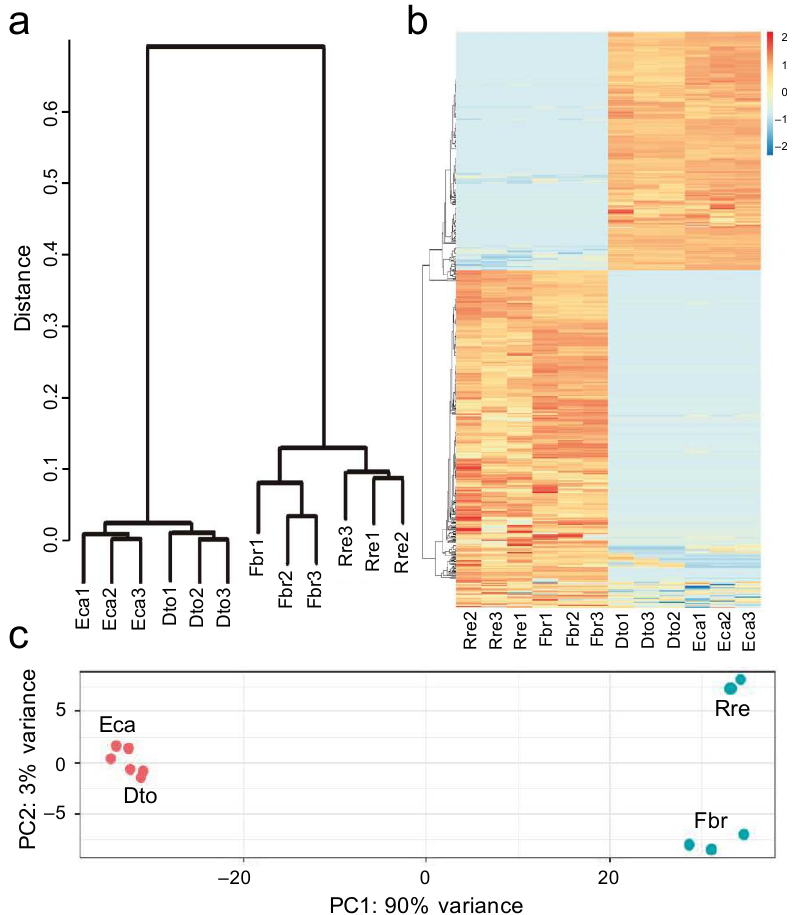
Figure 4. Analysis of differentially expressed genes (DEGs) between colpate pollen and porate pollen species. ( a ) Hierarchical clustering shows dissimilarity among the transcriptome samples; the distance was calculated by Pearson correlation coefficient. ( b ) Heatmap of DEGs between colpate and porate species; the heatmap scale bars indicate log 2 fold changes. ( c ) Principal component analysis of the transcriptome samples. Red points represent colpate species while blue points represent porate species. Eca, Eschscholzia californica ; Dto, Dactylicapnos torulosa ; Fbr, Fumaria bracteosa ; Rre, Roemeria refracta .